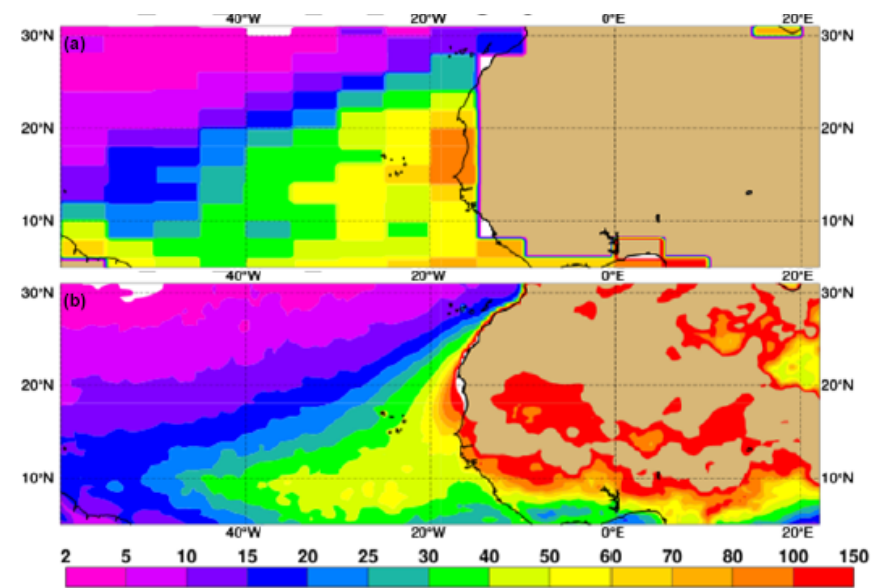
Figure 8. (a) The 2007–2016 mean dust total deposition (in mgm − 2 d − 1 ) as estimated by MODIS. (b) The mean 2017–2019 dust total deposition as simulated by IFS-AER cycle 47R1 without data assimilation (in mgm − 2 d − 1